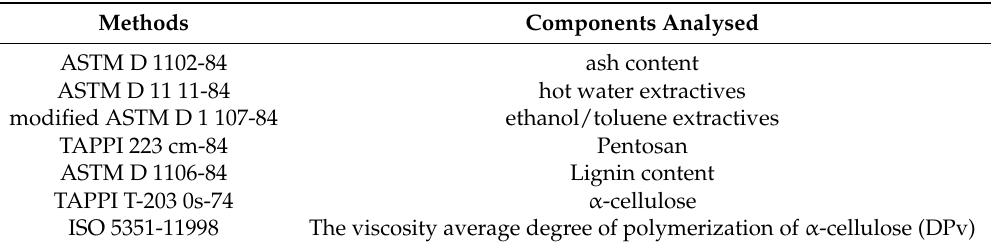
Table 1. Physicochemical analysis of